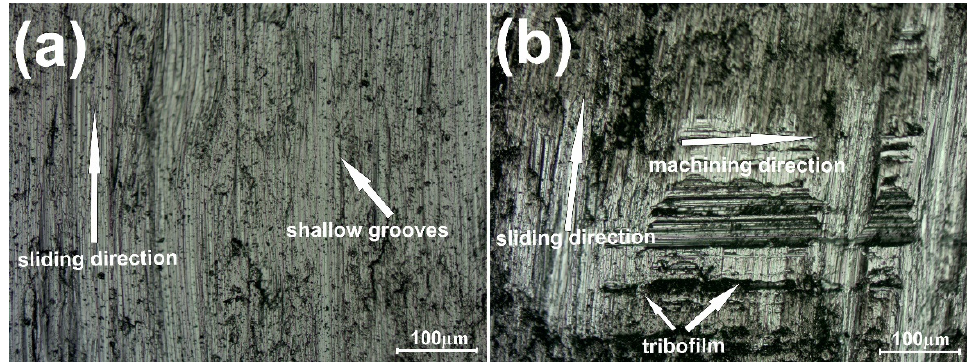
Figure 3. Surface condition of the counter-specimen mating with Ni-50%NiCr(80/20) ( a ) and Ni-